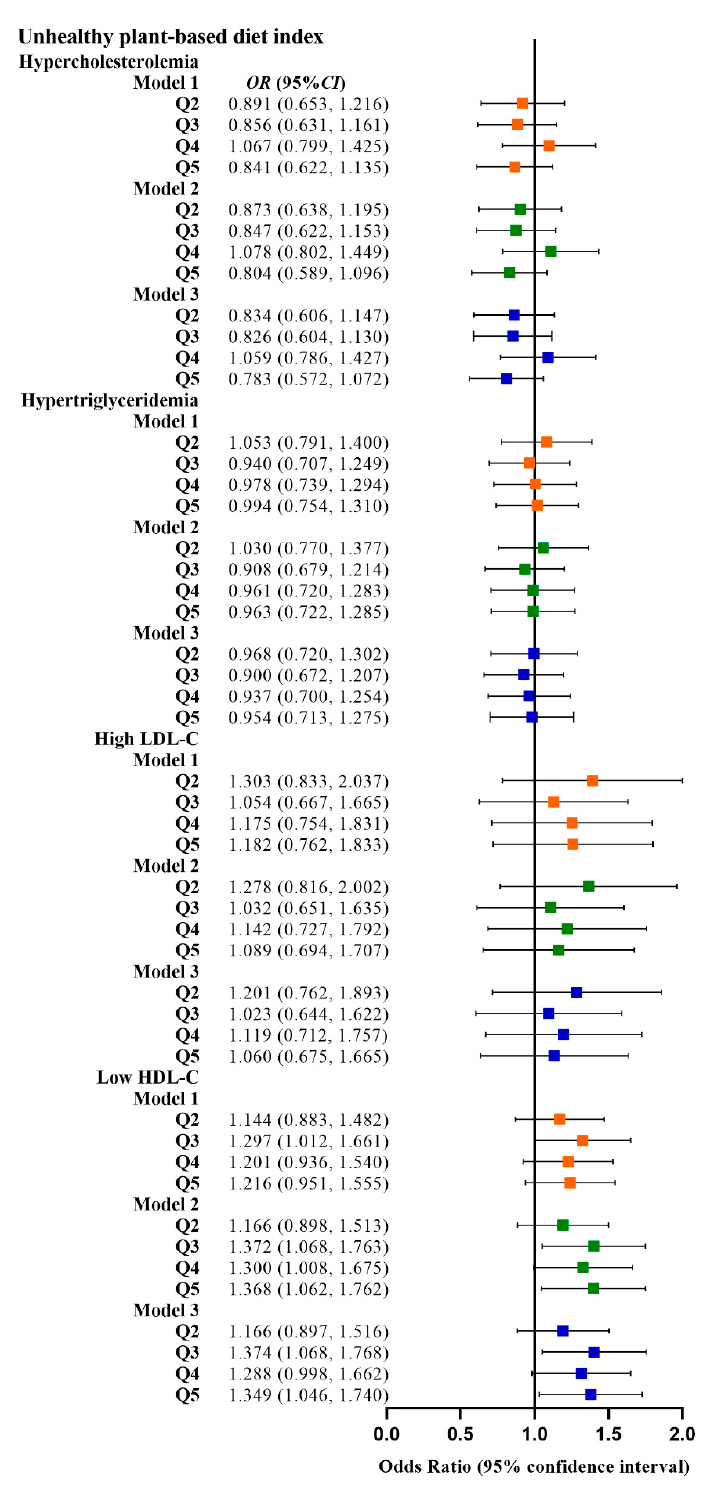
Figure 4. Odds ratios (OR) and 95% confidence intervals (CI) for uPDI with different types of dyslipidemia. The squares show odds ratios and the line ranges show 95% confidence intervals. Model 1: unadjusted; model 2: adjusted for sex, age, ethnicity, BMI, socio-economic status, smoking status, alcohol consumption, and physical activity; model 3: additionally adjusted for T2DM and hypertension.